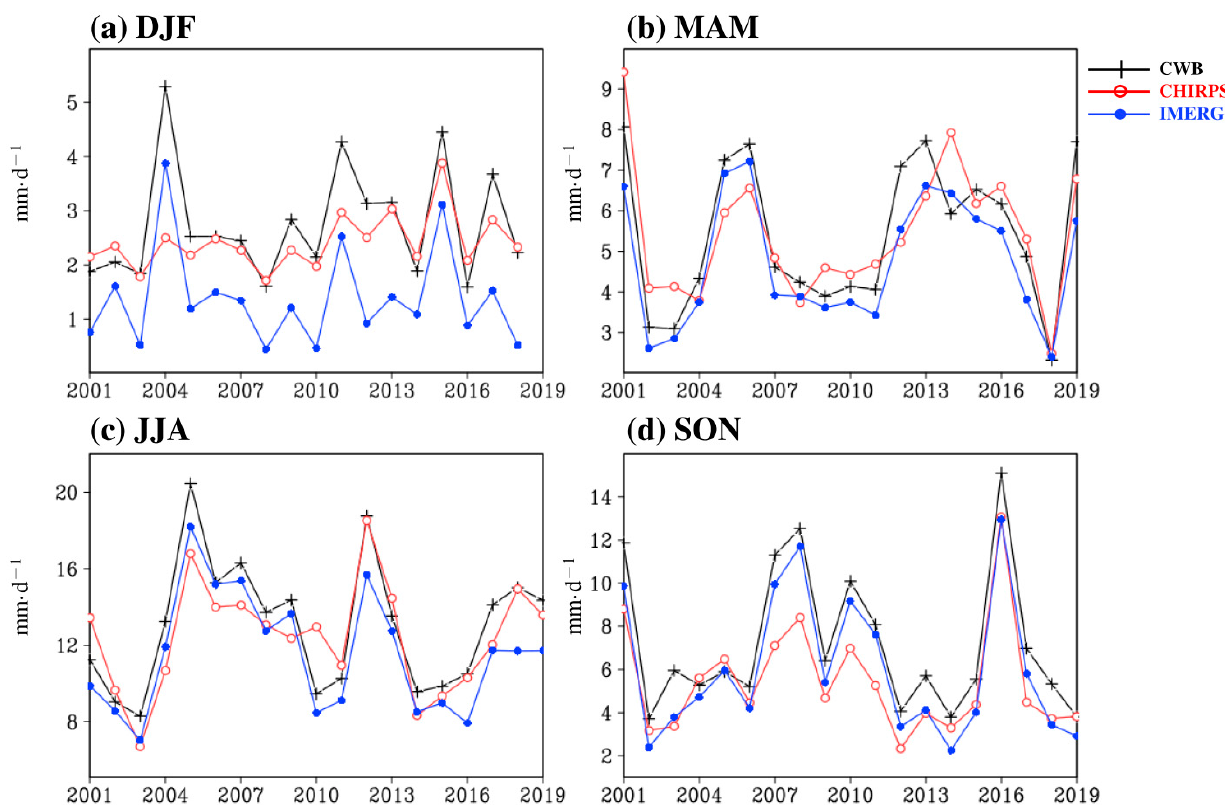
Figure 3. Time series of area-averaged seasonal mean precipitation over Taiwan during 2001–2019, estimated from CWB (black line), CHIRPS (red line), and IMERG (blue line) for four different seasons: ( a ) winter (December to February, DJF), ( b ) spring (March to May, MAM), ( c ) summer (June to August, JJA), and ( d ) autumn (September to November, SON).